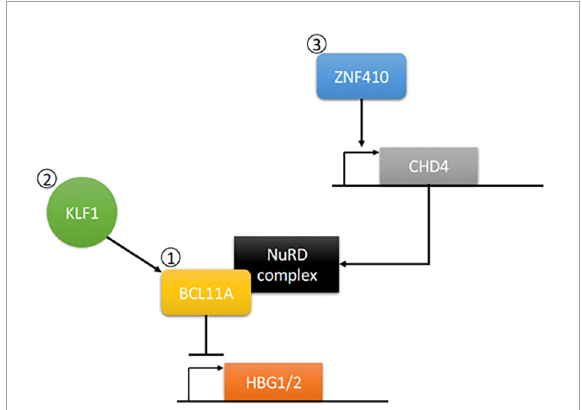
FIGURE1 Control of Gamma Globin Gene Transcription. Gamma globin production for the generation of fetal hemoglobin (HbF) occurs through the transcription of the HBG1/2 genes. (1) This can be negatively regulated through expression of B-cell lymphoma/leukemia 11A gene (BCL11A), which has been extensively studied in CRISPR knockout models for the induction of gamma globin expression (Frangoul et al. (13), Lamsfus-Calle et al. (25), Khosravi et al. (18), Wu et al. (17). (2) Kruppel-like factor 1 (KLF1) can directly activate gamma globin gene repressors such as BCL11A to play a role in switch from gamma to beta globin. CRISPR knockout studies of KLF1 have showed induction of gamma globin expression [Shariati et al. (21)]. (3) Zinc finger protein 410 (ZNF410) can regulate BCL11A repression of gamma globin gene expression via induction of the Nucleosome Remodeling Deacetylase (NuRD) complex component CHD4. BCL11A contains a motif that can interact with a variety of NuRD-associated molecules, thus allowing for activation and then subsequent repression of gamma globin gene expression. CRISPR knockout studies of ZNF410 have identified its role as a possible gene target for induction of gamma globin expression [Lan et al. (20)]. Speckle-type POZ protein (SPOP) not included in the